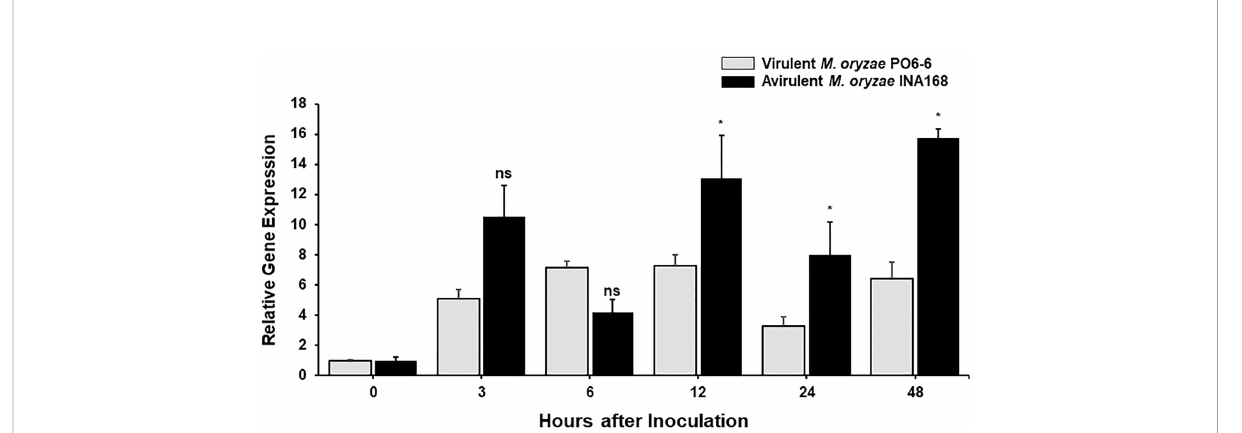
FIGURE 3 OsFER2 expression levels in leaf sheaths of rice HY in the compatible and incompatible interactions between rice and Magnaporthe oryzae . Rice leaf sheaths were inoculated with M. oryzae PO6-6 (virulent) and INA168 (avirulent). OsFER2 expression was analyzed by quantitative RT-PCR. Relative gene expression of OsFER2 at time points after inoculation were calculated by normalizing with respect to the expression of the internal control OsUbiquitin . The data represent the means ± SDs from the three independent experiments. Asterisks above the columns indicate signi fi cant differences as analyzed by Student ’ s t -test (* P <0.05). ns, not signi fi